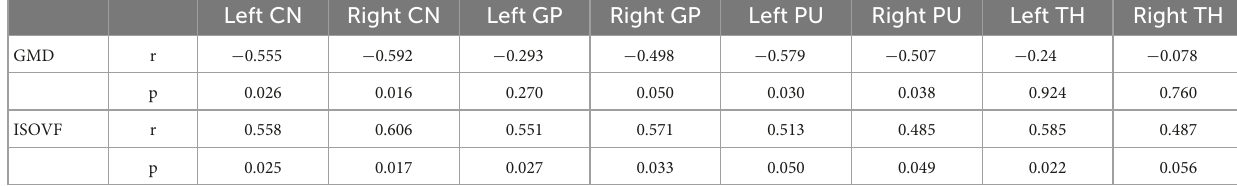
TABLE 2 Correlation analysis between UWDRS score and GMD and ISOVF values. Left CN Right CN Left GP Right GP Left PU Right PU Left TH Right